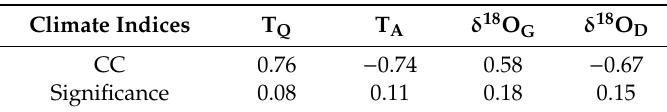
Table 1. Linear Pearson correlation coe ffi cients (CC) between SSN and climate indices for their millennial-cycle